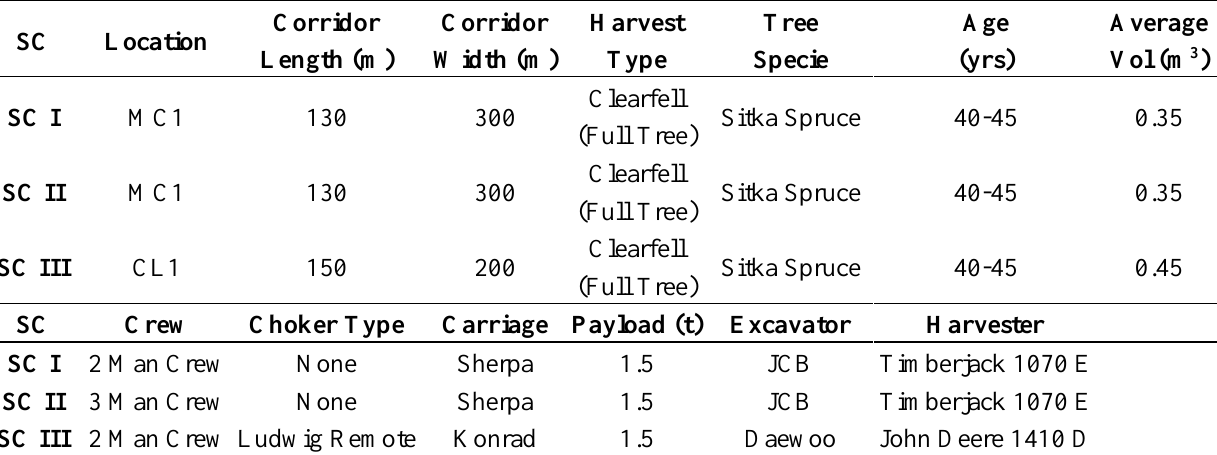
Table 1. Summary description of scenario layouts.